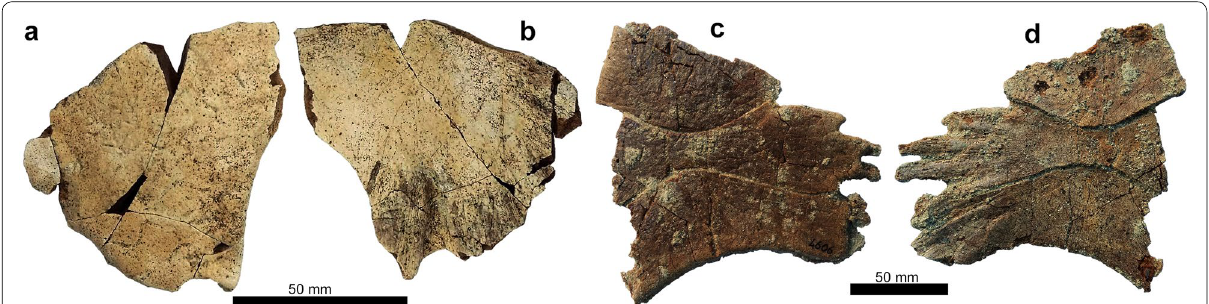
Fig. 5 Pan-Cheloniidae indet. from Cessaniti; plastral material. a – b F ragment of left hypoplastron (MSNC 4602) in ventral ( a ) and dorsal ( b ) views; c – d plastral fragment (MSNC 4606) in ventral ( c ) and dorsal ( d )